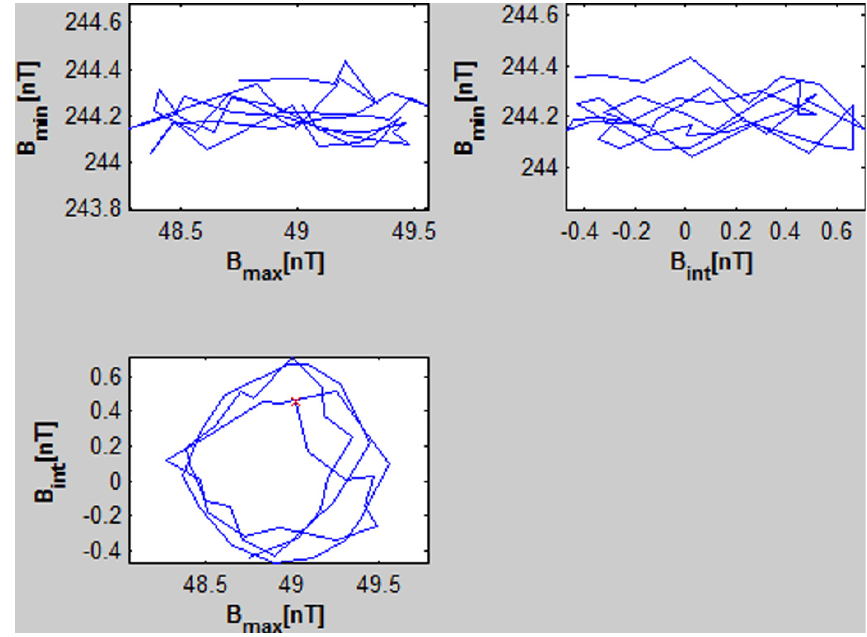
Fig. 5. Hodogram representation of a fragment of the same wave packet as in Fig. 3 seen from the Cluster 4 fluxgate magnetometer data. B max , B int and B min signify maximum, intermediate and minimum variance eigenvectors respectively. The bottom panel shows the wave projected along the axis of minimum variance (coming out of the page). The red cross marks the beginning of the time series. Left-hand circular polarisation is clearly visible.